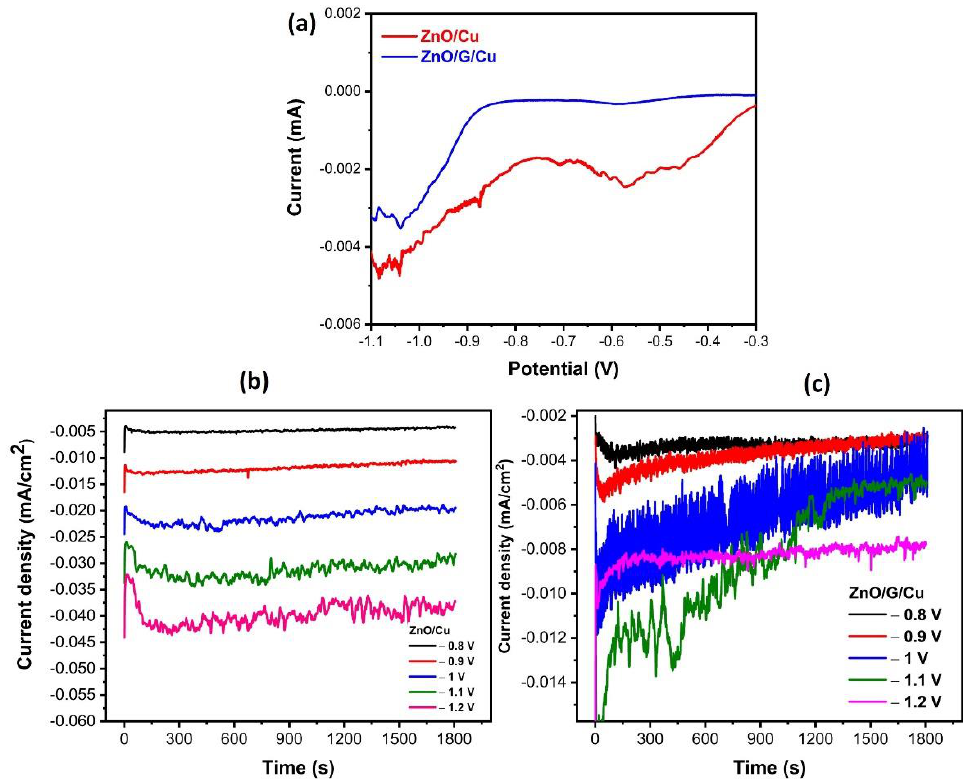
Figure 2. ( a ) Electrochemical polarization curve for ZnO electrodeposition on Cu and G/Cu. Current versus time curves at different deposition potentials for ( b ) ZnO/Cu and ( c ) ZnO/G/Cu.